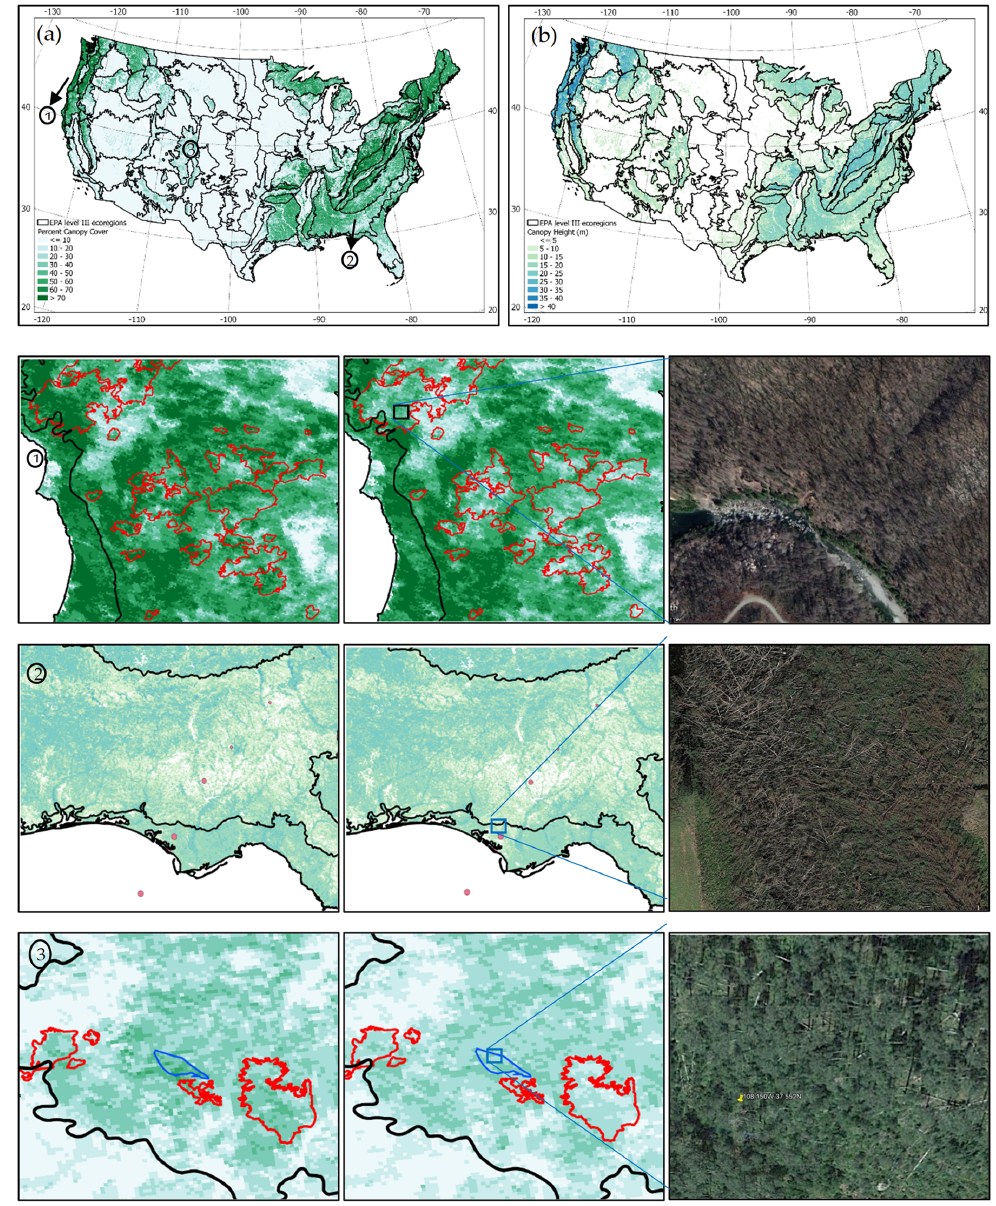
Figure 7. ( a ) 2020 wall − to − wall VIIRS − derived canopy cover map, and ( b ) 2020 wall − to − wall VIIRS − derived canopy height map. From right to left: panel ① shows canopy cover in 2013 prior to fire disturbance events (red polygons are the MTBS fire disturbance boundaries occurring between 2014 − 2019) and canopy cover in 2020 after the fire disturbance vents; panel ② shows canopy height in 2017 (left) and 2020 (right) showing the impacts of Hurricane Michael 2019 on derived canopy height; panel ③ demonstrates the ability of the maps to detect “more” subtle changes in canopy cover associated with selective logging (blue polygon). High-resolution satellite image insets visually demonstrate post-disturbance impacts on vegetation structure.